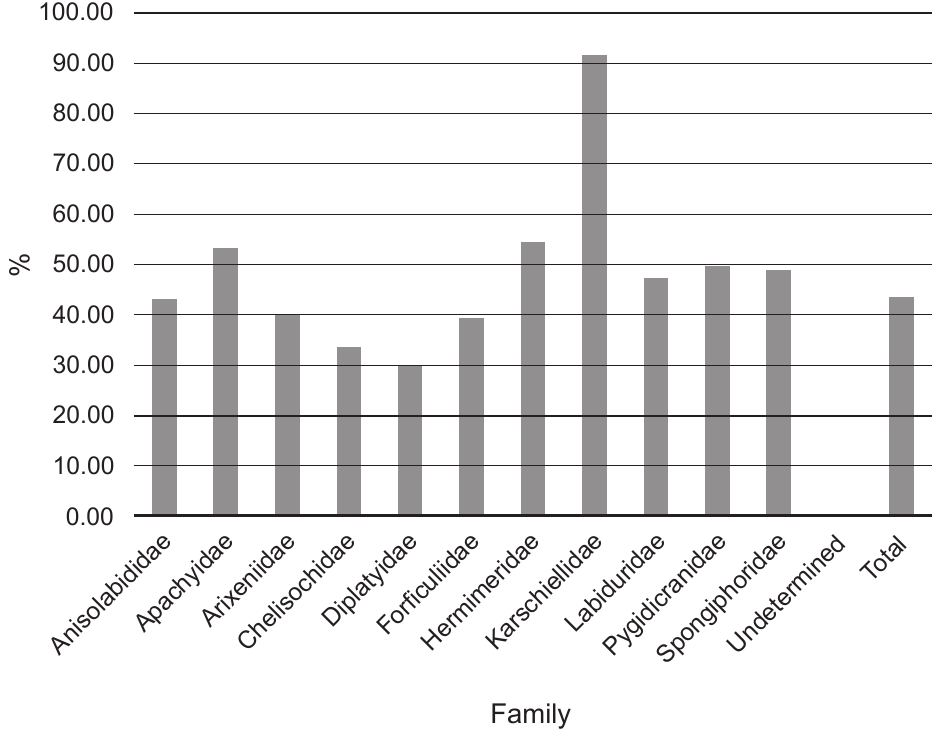
Fig. 2. A graph showing % of World Dermaptera represented at the Manchester Museum, by